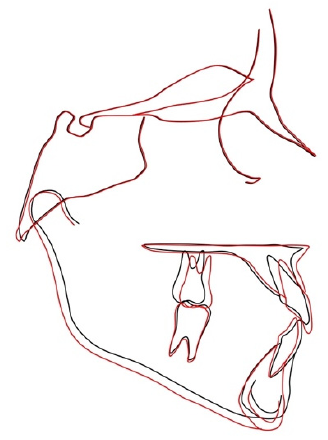
Figure 8. Superimposition of pretreatment (black) and posttreatment (red) cephalometric tracings on the stable basicranial structures.